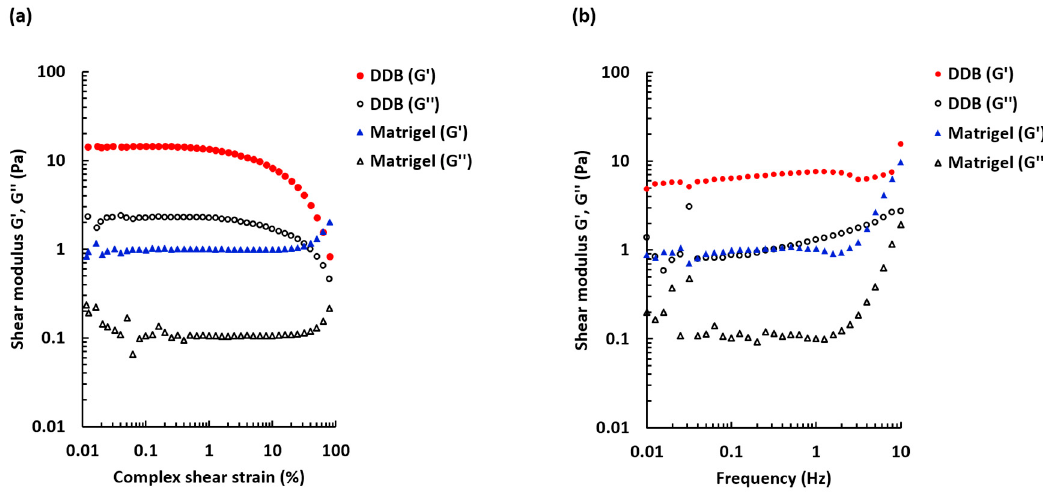
Figure 3. Amplitude and frequency sweep tests for 30 mg/mL DDB gel and 1.5 mg/mL Matrigel gel. ( a ) The storage modulus G’ and loss modulus G’’ dependence on shear strain over a range 0.01–100%. Oscillation frequency 1 Hz, T = 37 °C. Mean n = 3–4. ( b ) The frequency sweep comparing G’ and G’’ over a frequency range 0.01–10 Hz. Shear strain 0.0005, T = 37 °C. Mean n = 3–4.